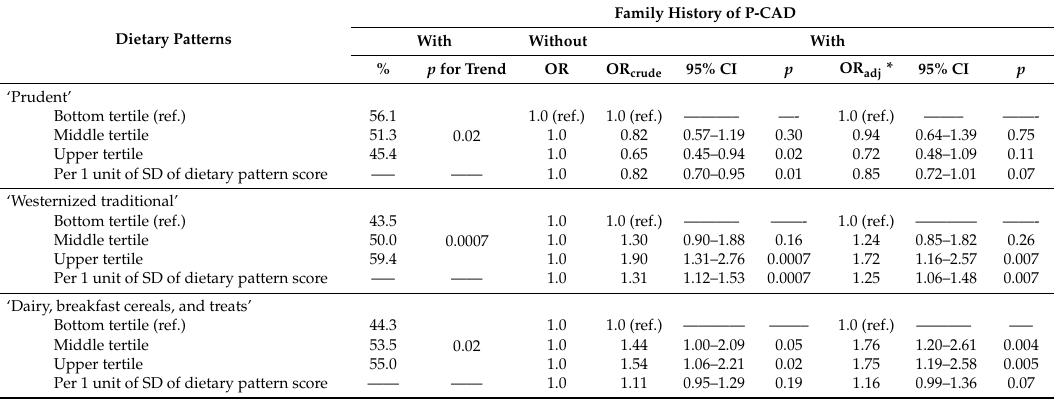
‘Dairy, breakfast cereals, and treats’ Bottom tertile